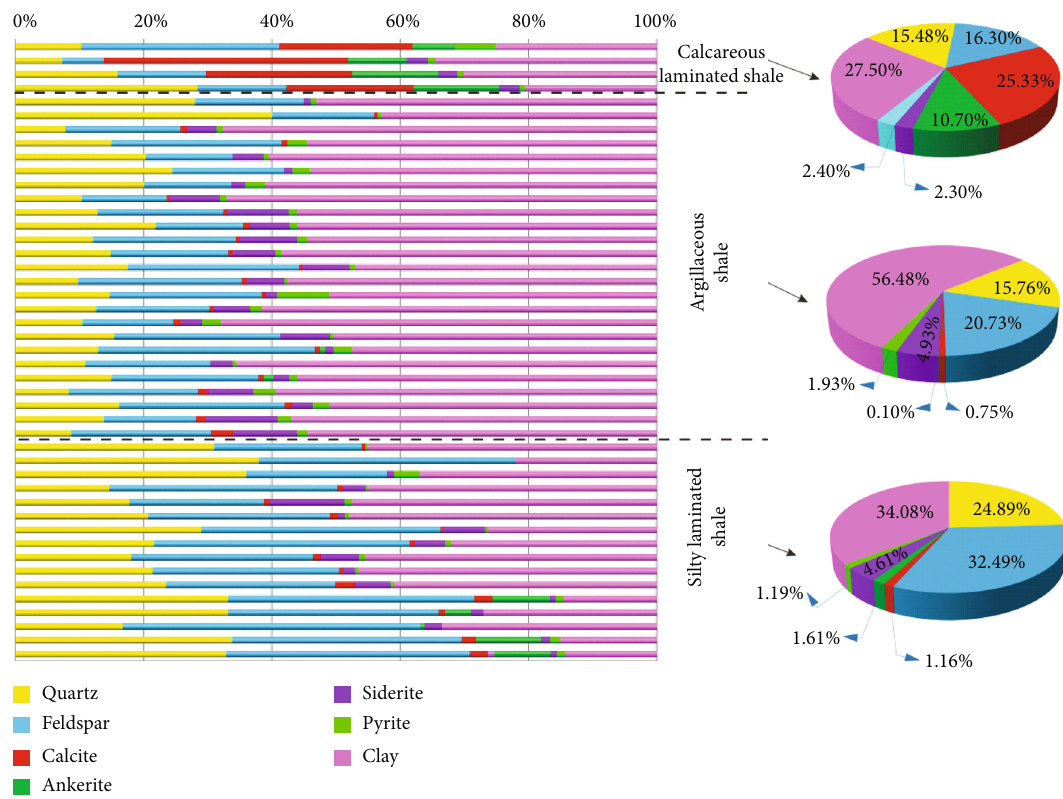
Figure 5: Mineral content of the studied area in Chang 7. Table 2: North America Shale and Chang 7 Shale elemental